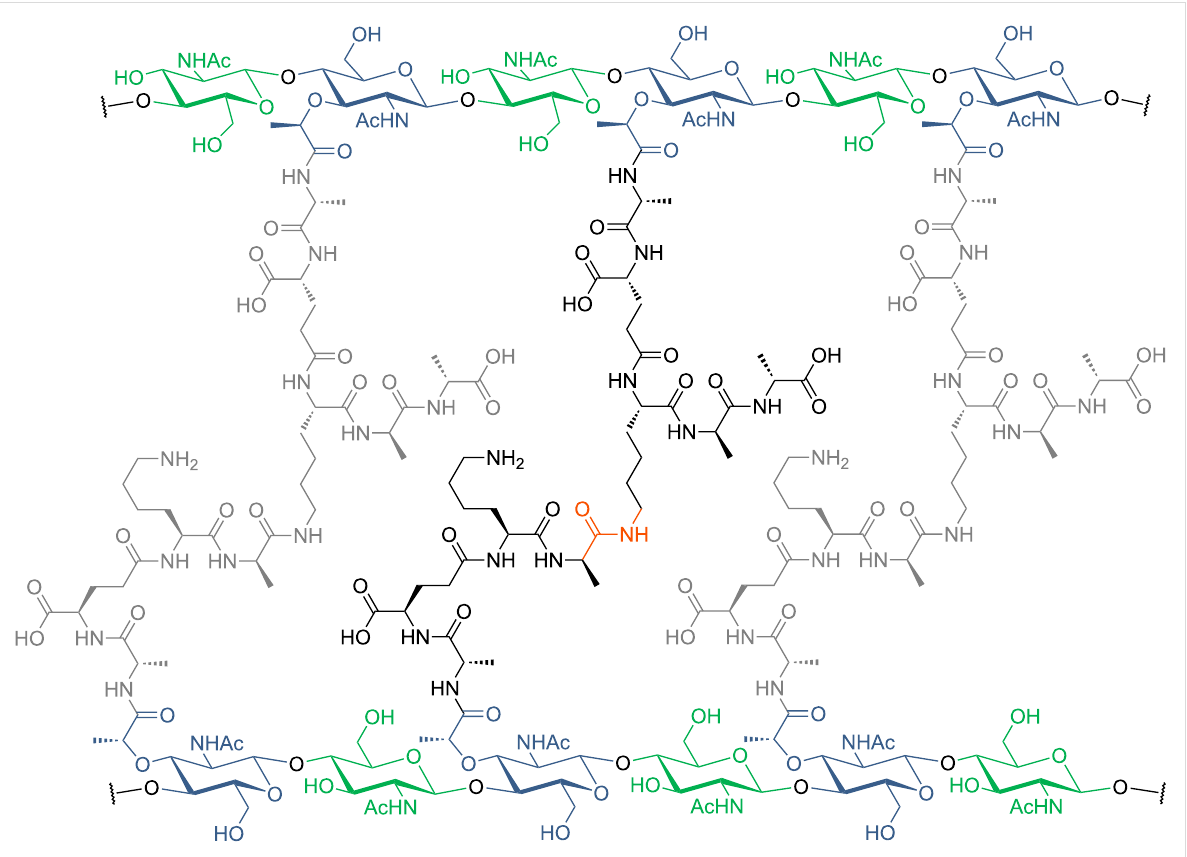
Figure 3: Structure of peptidoglycan. Long chains of glycosides (alternating Glc N Ac (green) and Mur N Ac (blue)) are cross-linked through the Mur N Ac peptide chain. The exact composition of the peptide chain varies among different bacterial species.